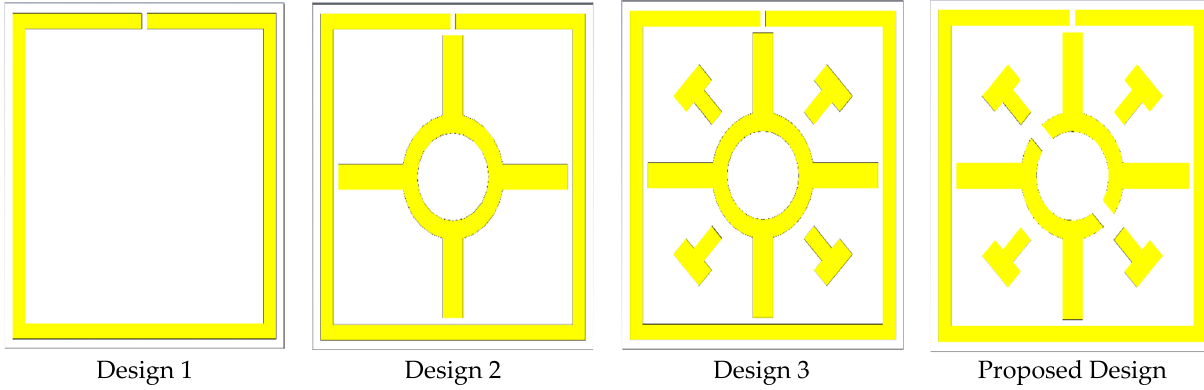
Figure 3. Different design approach towards finalizing the desired design.